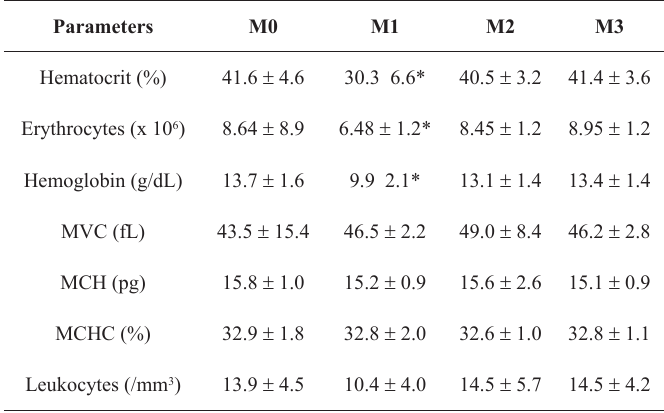
TABLE 1 - Average values and standard deviation of the hematological parameters evaluated before (M0) and 2, 24, and 48 hrs (M1, M2, and M3) after the renal